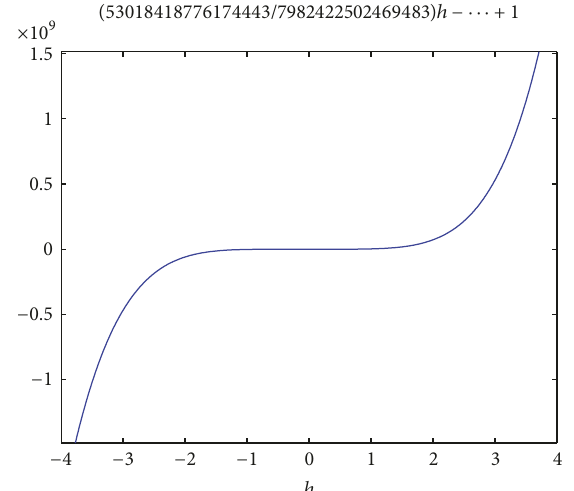
Figure 3: The ℎ -curves obtained from the 6th-order HAM approx- imate solution for Caputo logistic equation.